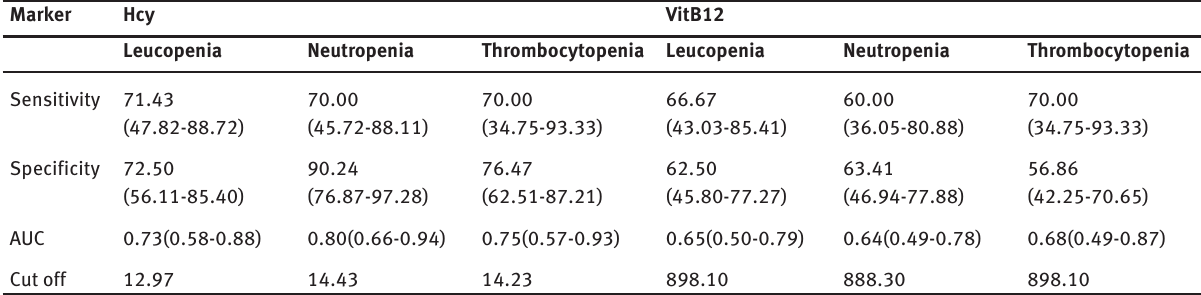
Table 4: Severity of haematological toxicity prediction by serum Hcy and VitB12 (95%CI). Marker